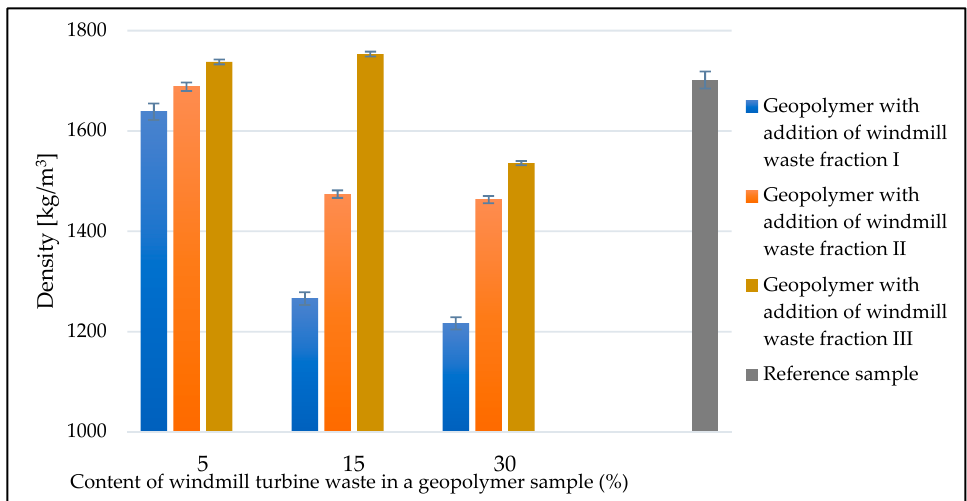
Figure 9. Medium density of geopolymer materials with addition of windmill fractions.